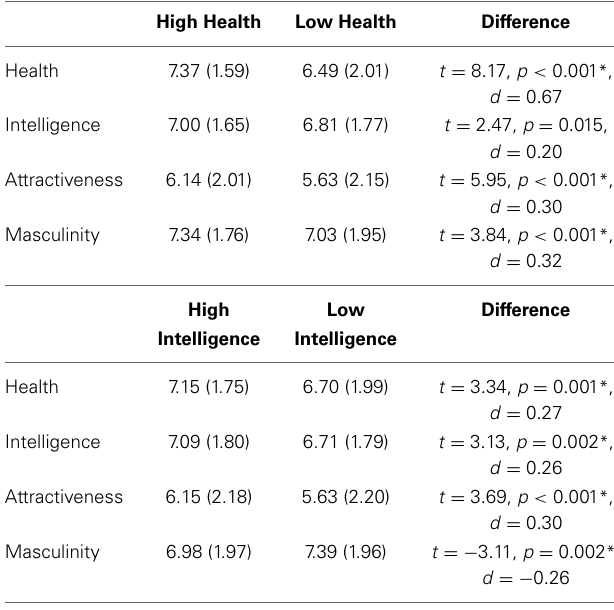
Table 1 | Sample 1 ( N = 105) Ratings of high health vs. low health faces, and ratings of high intelligence vs. low intelligence faces—Means, SDs, t -tests, and Cohen’s Ds.